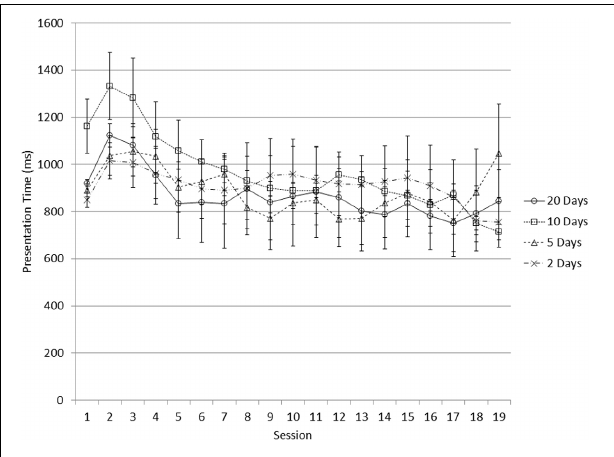
FIGURE 1 | Presentation time decreased with training on the Animal task; error bars represent standard